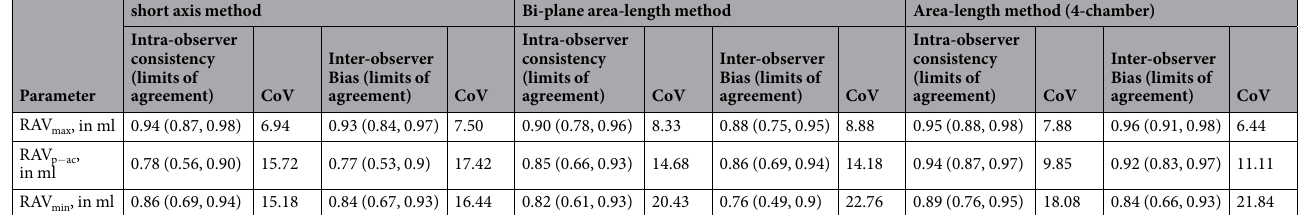
Table 11. Inter- and intra-variability in right atrial volumes (n = 135). RAV max, maximal right atrial volume; RAV p − ac , right atrial volume before atrial contraction; RAV min, minimal right atrial